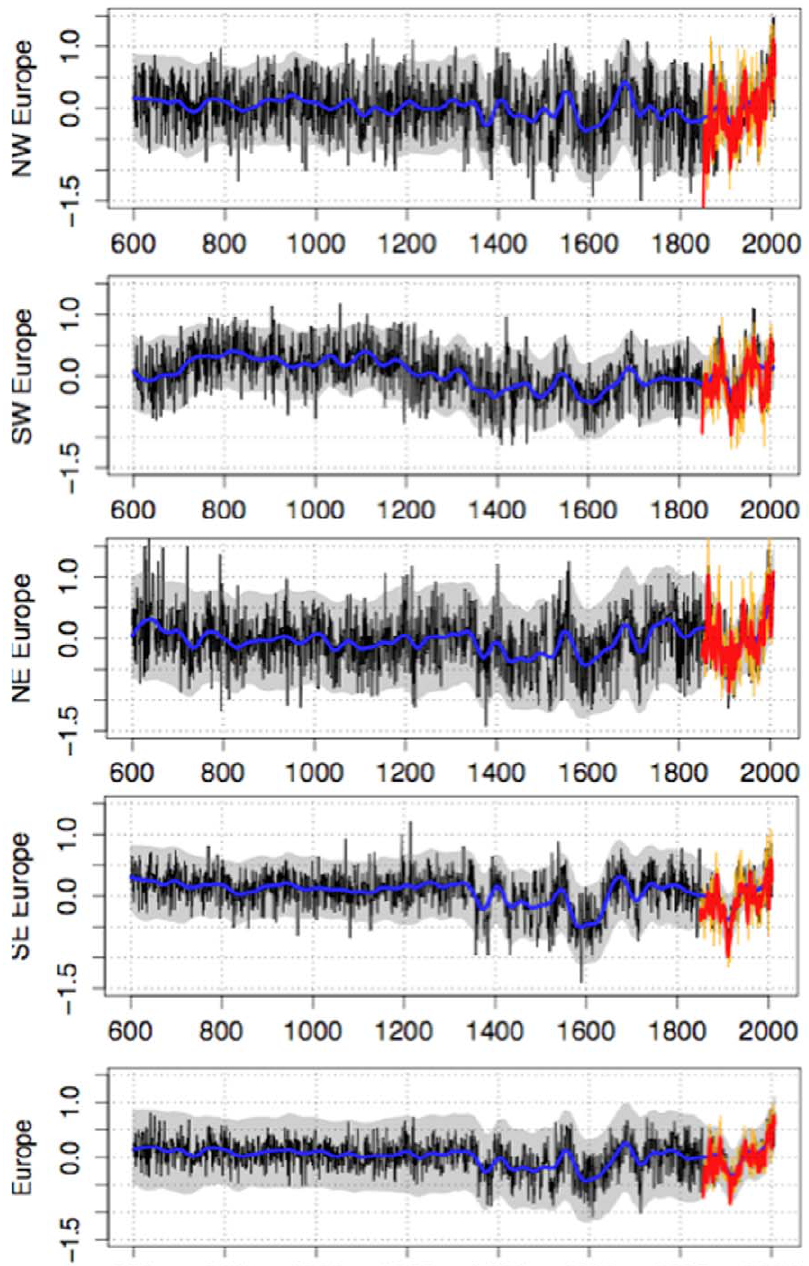
Figure 8. Mean April to September temperature anomalies averaged on various parts of Europe. The black lines represent the reconstructions, the smoothed smoothed confidence interval at 95% are displayed in grey, the blue line is the smoothed reconstruction, orange and red lines are respectively raw and smoothed observations. (a) Eur_SW, Europe south of 45 u N and west of 20 u E, (b) Eur_SE, Europe south of 45 u N and east of 20 u E, (c) Eur_NW, Europe north of 45 u N and west of 20 u E, (d) Eur_SE, Europe south of 45 u N and east of 20 u E, (e) Eur_mean, whole of Europe. The gridpoints for which RE , 0 were excluded from the average.